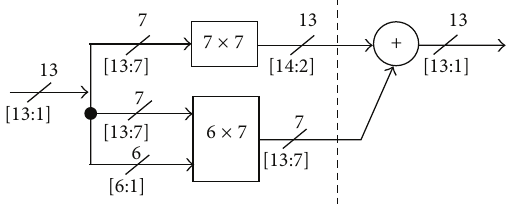
Figure 12: The 13-bit squarer circuit.